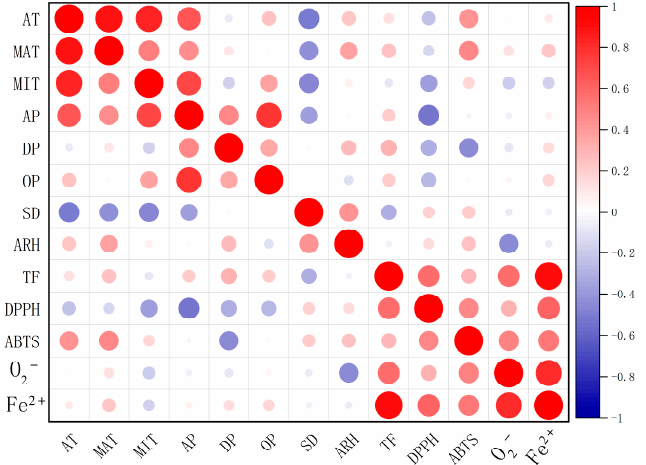
Figure 6. The correlation coefficient matrix between TFC, antioxidant activity of W. japonica and climate factors.